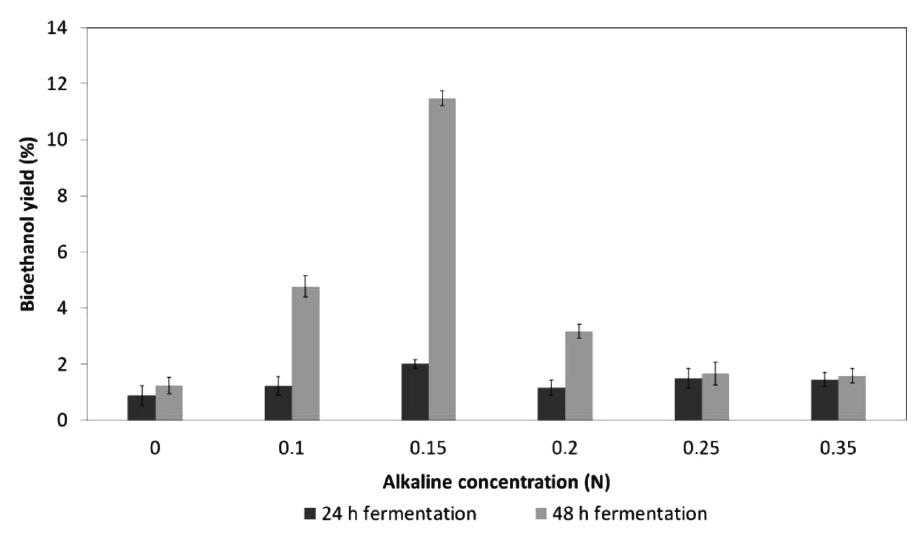
Fig. 2 – Bioethanol yields obtained from alkaline pre-treated macroalgae (pre-treatment temperature: 100 °C, pre-treatment time: 60